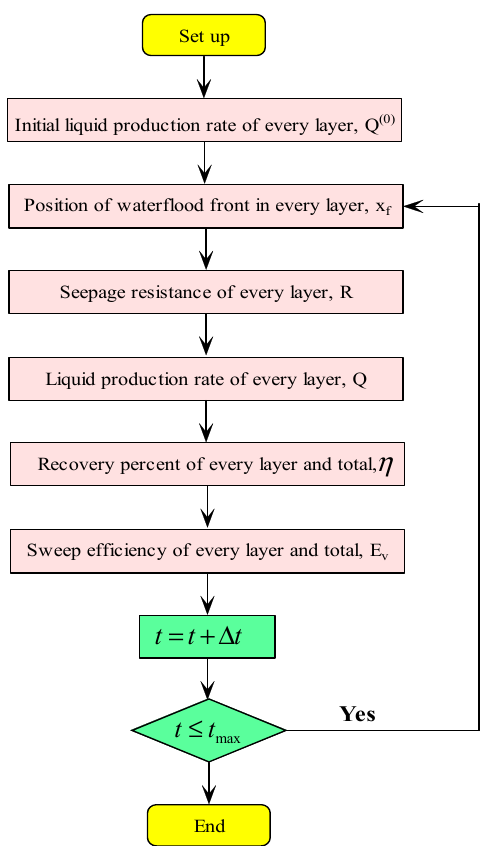
Figure 3. Flow chart for solving the multilayer water flooding model.